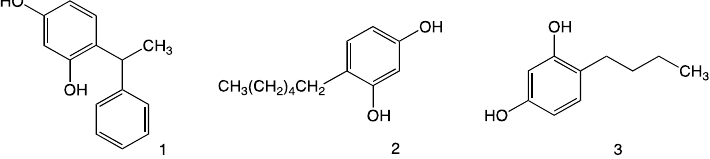
Figure 1. Chemical structures of (±)-phenylethylresorcinol ( 1 ), 4-hexylresorcinol ( 2 ) and 4-butyl-resorcinol ( 3 ).